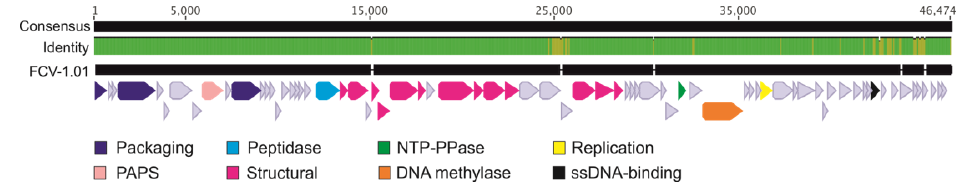
Figure 5. Genome alignment of the ancestral FCV-1 (accession number KY979235.1) and the adapted phage FCV-1.01 (accession number MT431535) displaying the genome consensus and FCV-1.01 with predicted open reading frames (ORFs) as arrows. Identity is displayed as green (100% identity) and yellow (the locations of differences between the two genomes). Breaks in the FCV-1.01 bases indicate the locations of deletions compared to FCV-1. Putative functions are shown in colors indicated in the bottom and the light blue arrows indicate the hypothetical proteins. PAPS stands for phosphoadenosine phosphosulfate sulfurtransferase, NTP-PPase for nucleoside-triphosphatase.